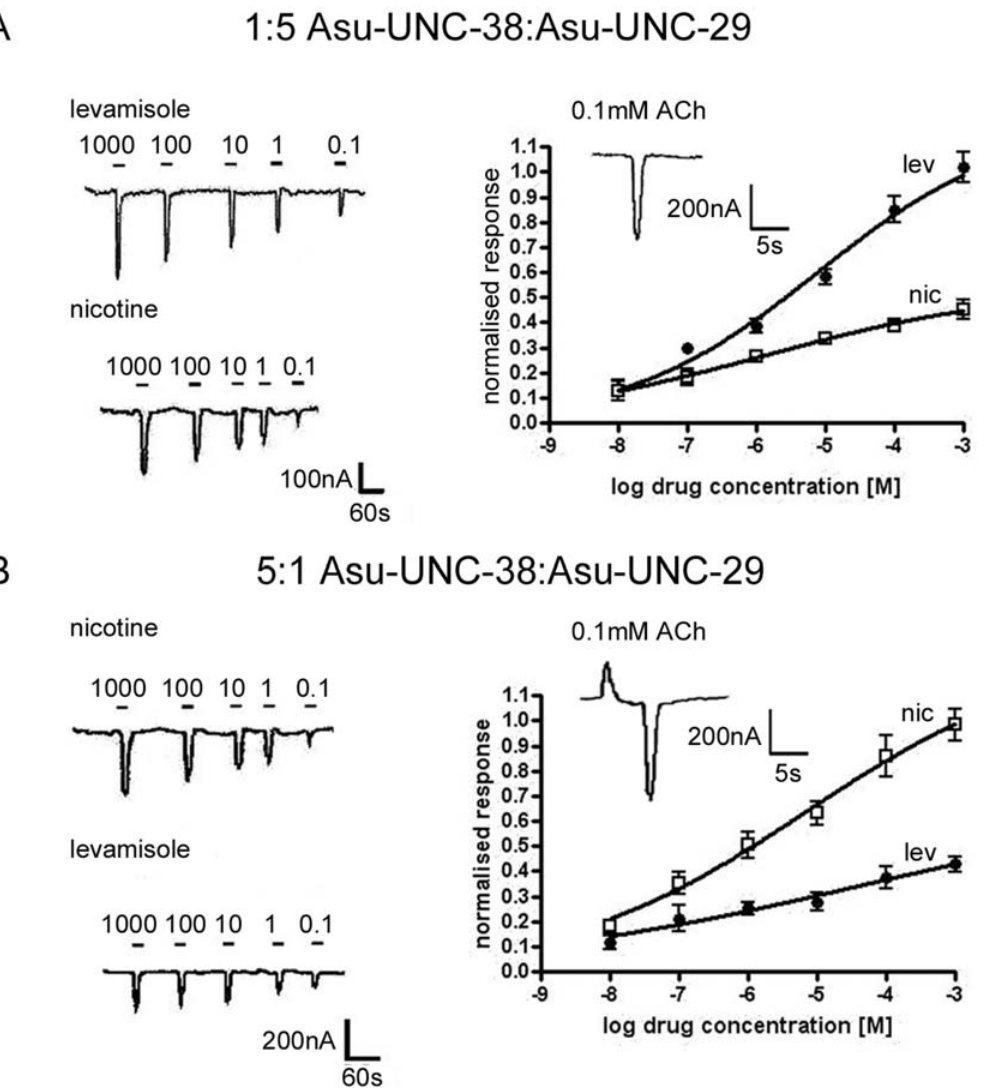
Figure 4. Levamisole and nicotine responses from oocytes injected with cRNAs at 5:1 and 1:5 ratios. A) Levamisole and nicotine responses from oocytes injected with a 1:5 ratio of Asu-unc-38 and Asu-unc-29 . The currents evoked by levamisole application are larger than those produced by nicotine application. Agonist application is indicated by a bar above the trace, and the concentrations are indicated in m M. The dose- response relationships for levamisole and nicotine are derived from N=3 n=6 minimum for each data point, where n=number of oocytes tested, N=number of frogs from which the oocytes were obtained. Levamisole acts as a full agonist on this receptor subtype, whereas nicotine acts as a partial agonist. All responses were normalized to the response to 100 m M acetylcholine: an example of such a response is shown as the inset. B) Nicotine and levamisole responses from oocytes injected with a 5:1 Asu-unc-38:Asu- unc-29 ratio. The currents evoked by nicotine application are larger than those produced by levamisole application. Agonist application is indicated by a bar above the trace, concentrations are given in m M. The dose-response relationships for levamisole and nicotine, where N=3 n=6 minimum for each data point. Nicotine acts as a full agonist on this receptor subtype, whereas levamisole acts as a partial agonist. All responses were normalized to the response to 100 m M acetylcholine, an example of which is shown.